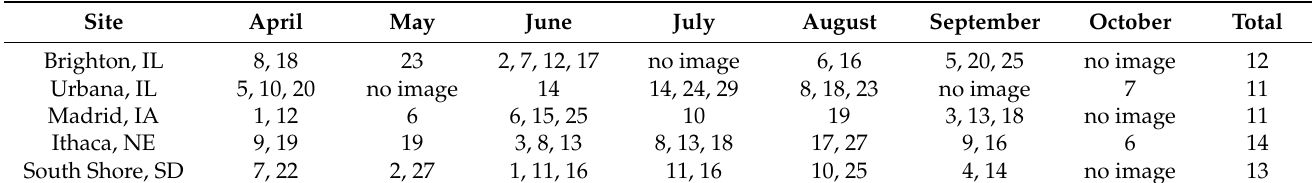
Table 3. Summary of imagery considered for model development.